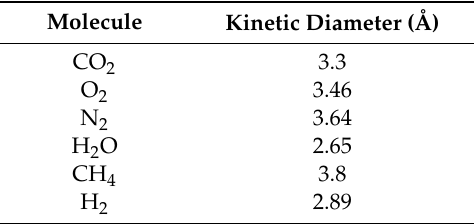
Table 1. Kinetic diameters of several gases [14].